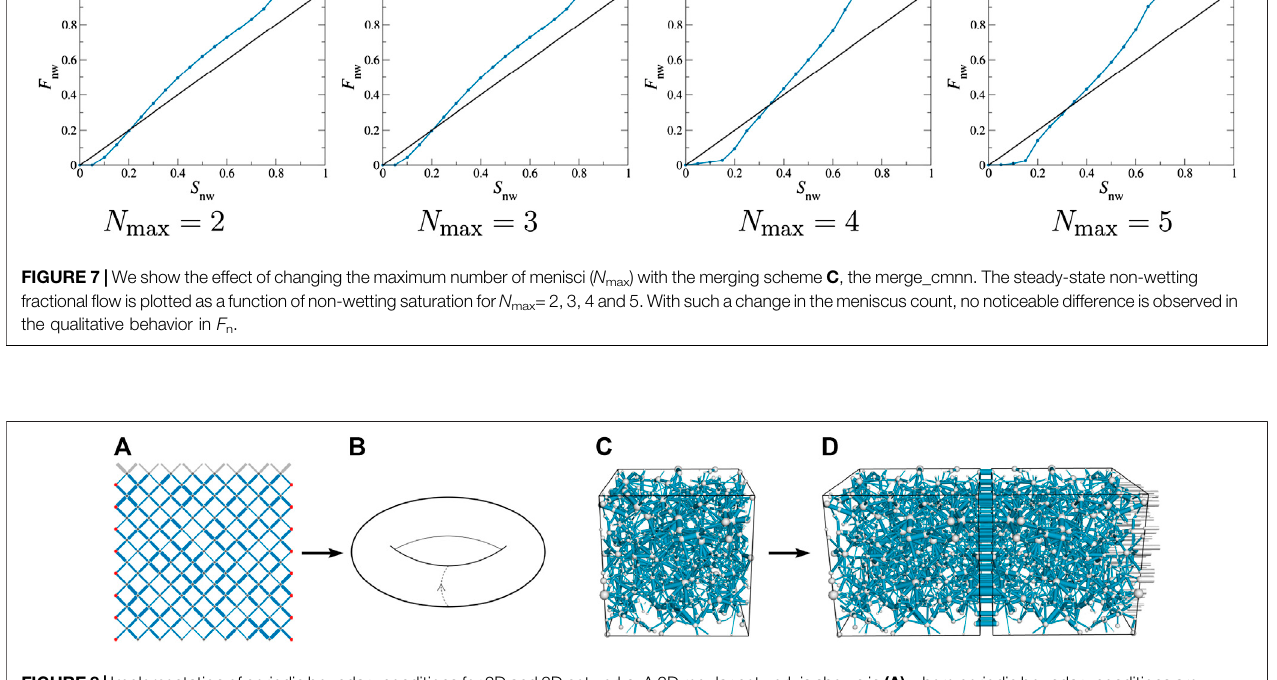
Frontiers in Physics |